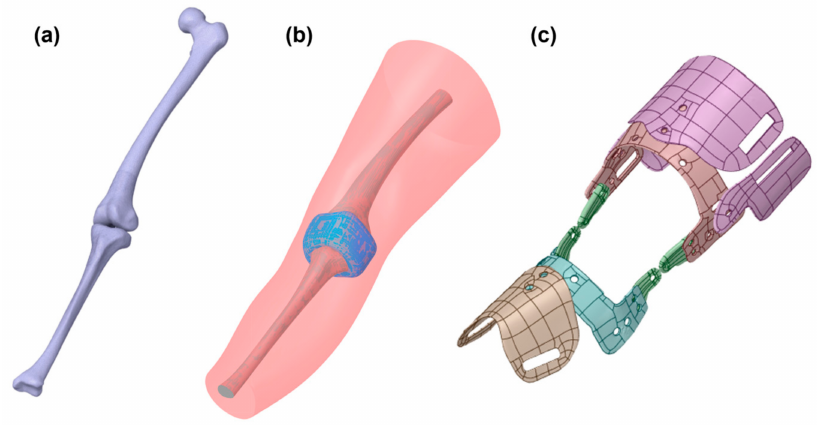
Figure 3. ( a ) Femur and tibia reconstruction; ( b ) Lower limb assembly for the FEA; ( c ) Bracket assembly after reverse engineering reconstruction.